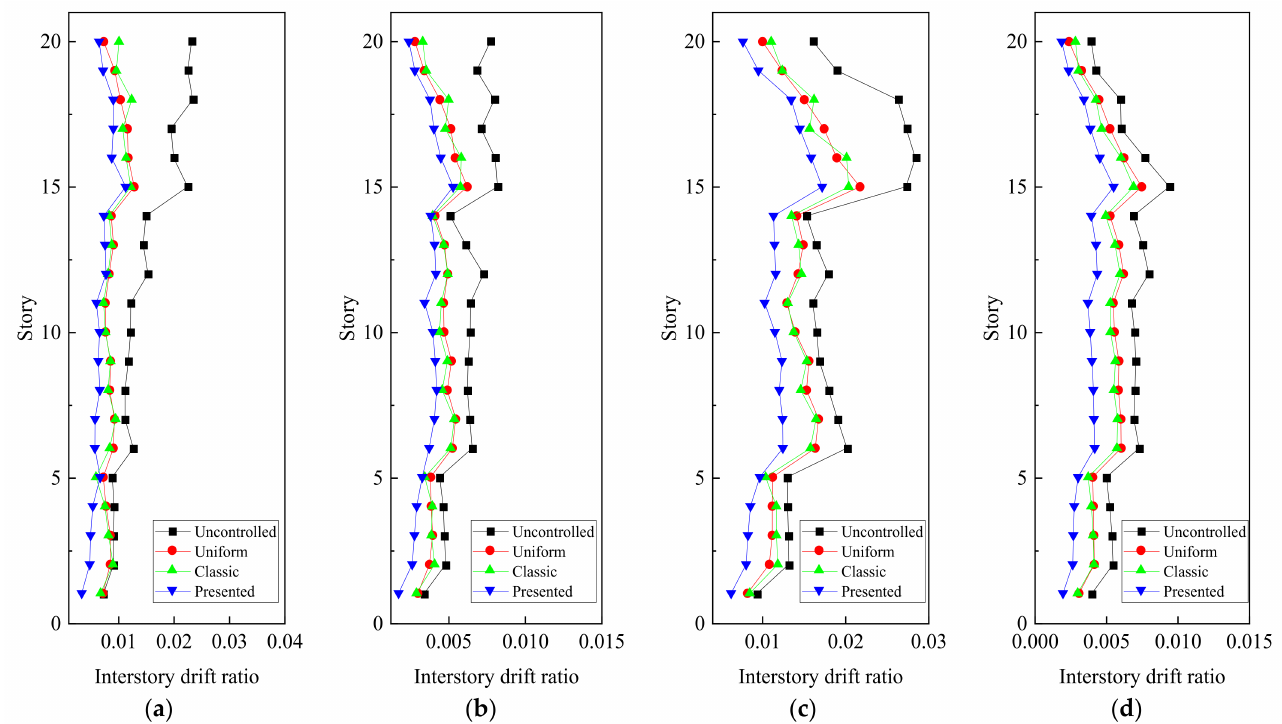
Figure 7. Maximum inter-story drift ratio of each story with different actuator placement: ( a ) Kobe; ( b ) El-Centro; ( c ) Tabas; ( d ) Artificial seismic wave.